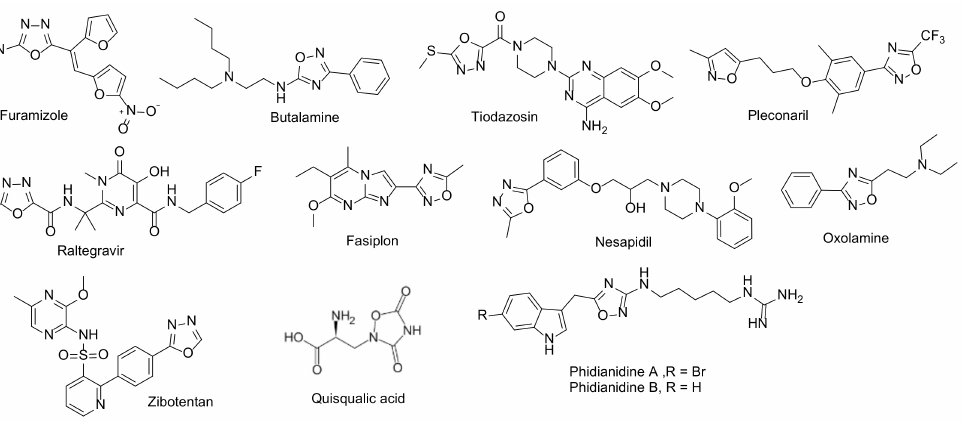
Figure 1. Representative drugs and natural products containing the oxadiazole